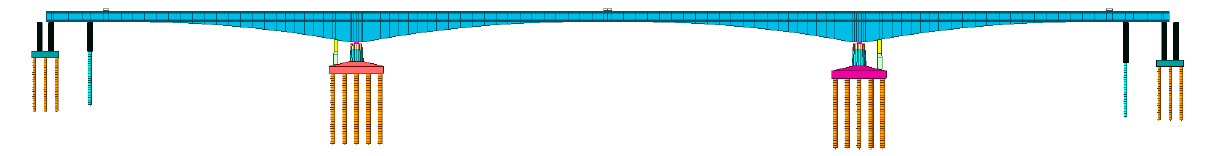
Figure 5. Global analysis